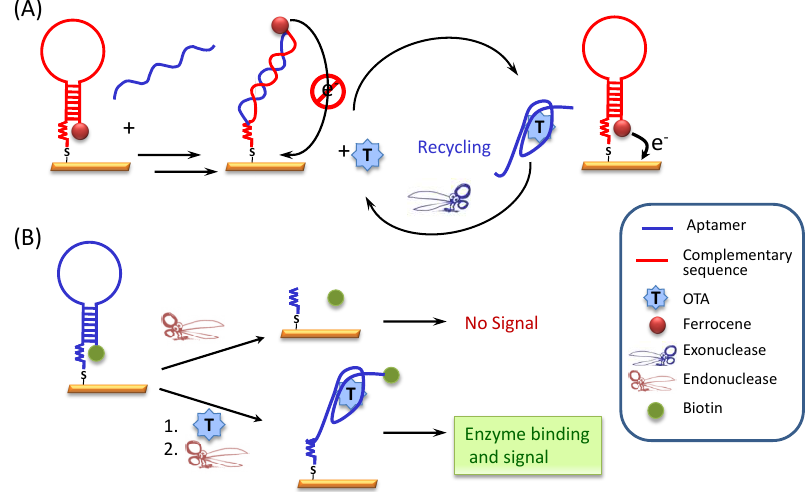
Figure 4. Ultrasensitive detection of OTA using ( A ) an exonuclease for target recycling; and ( B ) an